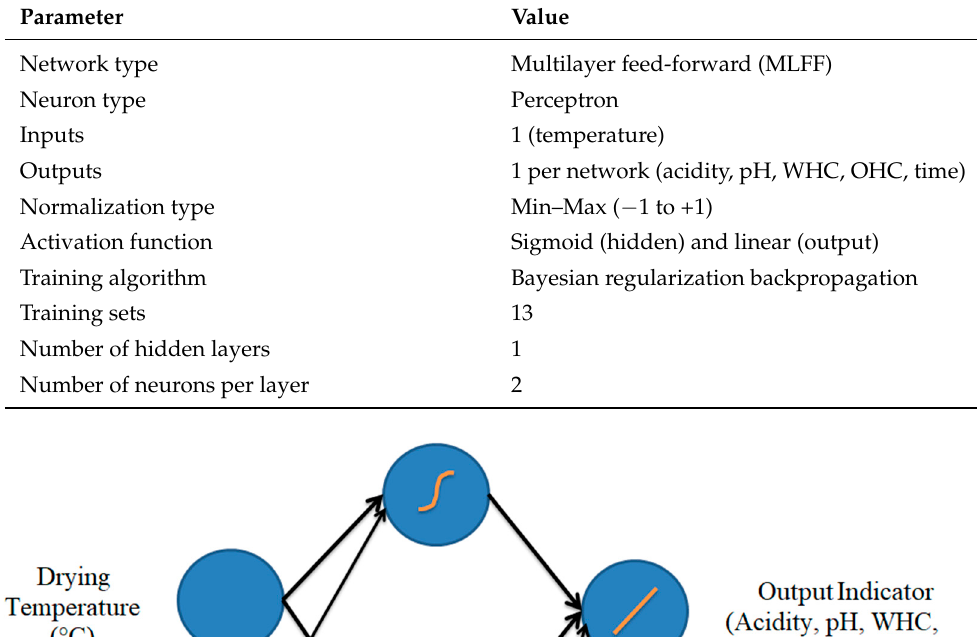
Table 1. Neural model summary.